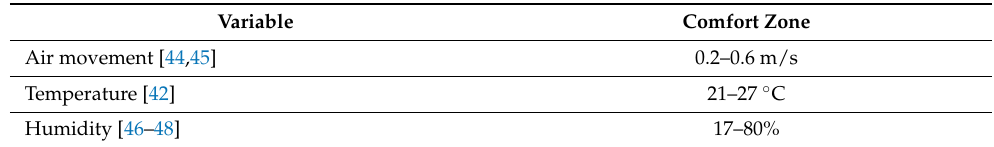
Table 2. Research control variables.